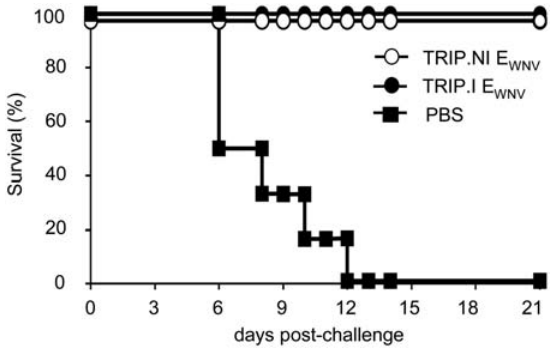
Figure 5. Efficient long-term protection against WNV infection by nonintegrative lentiviral vector-based vaccine. Two months post-immunization with graded doses (1–100 ng of p24 antigen) of TRIP.NI E WNV or TRIP.I E WNV particles, groups of mice (6 mice per group) were inoculated with 1,000 i.p. LD 50 s of WNV strain IS-98-ST1. Survival was recorded for 21 days. Data are representative of three independent experiments.